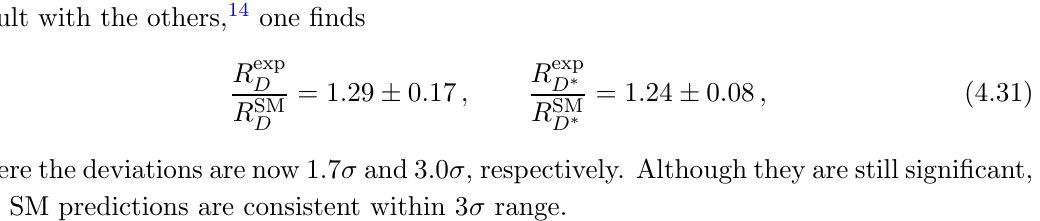
Table 3 . Theoretical input to evaluate (cid:13)avor observables described in the main